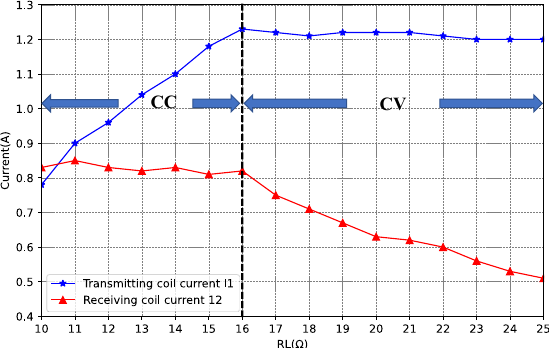
Figure 13. The current I 1 of the transmitting coil and the current I 2 of the receiving